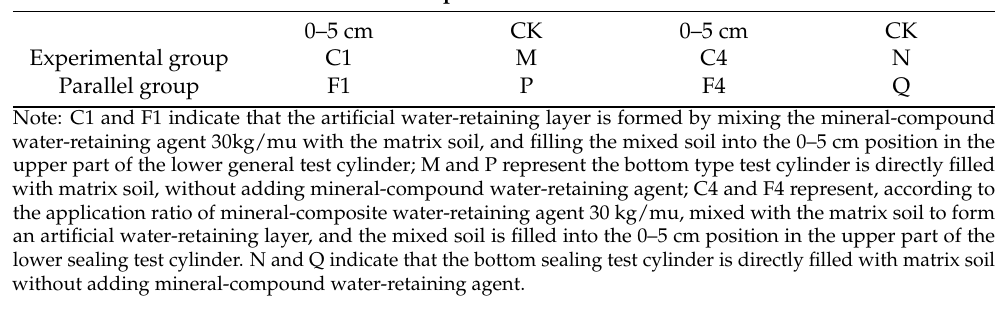
Table 1. Experimental arrangement table. Underpass Under Sealed 0–5